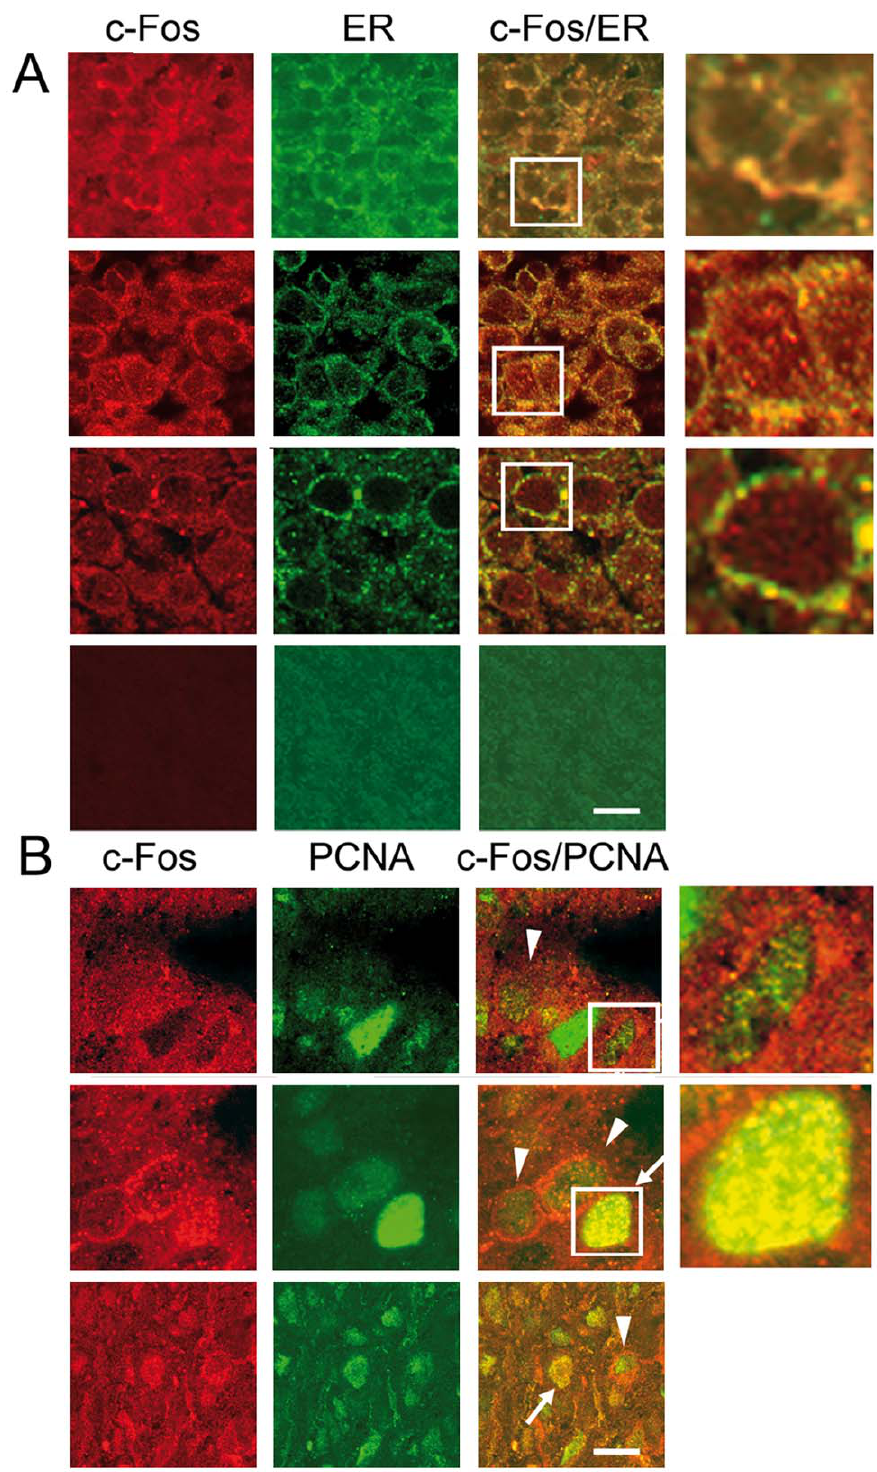
Figure 1. Human brain tumors show abundant c-Fos expression co-localizing with the ER marker calnexin. ( A ) Expression of c-Fos, the ER marker calnexin, and the nuclear marker of proliferating cells PCNA in human brain tumor specimens (n=156) and non-pathological samples (n=17). Representative samples of astrocytoma (1st row), GM (2nd row), medulloblastoma (3rd row) and human brain non-pathological samples (4th row) from a tissue array immunostained for c-Fos (red) and calnexin (green); 3rd column is the merge of the previous two columns. Yellow color evidences c-Fos/ER co-localization sites. ( B ) Immunostaining for c-Fos (red), PCNA (green) and the merged image of both is shown for an astrocytoma (1st row), a GM (2nd row) and a medulloblastoma (3rd row). Arrows: proliferating cells with nuclear c-Fos; arrowheads: cells showing predominantly peri-nuclear c-Fos. Bar: 20 m m. Fourth column in A and B is a 20 6 magnification of the boxed area in the 3rd column.